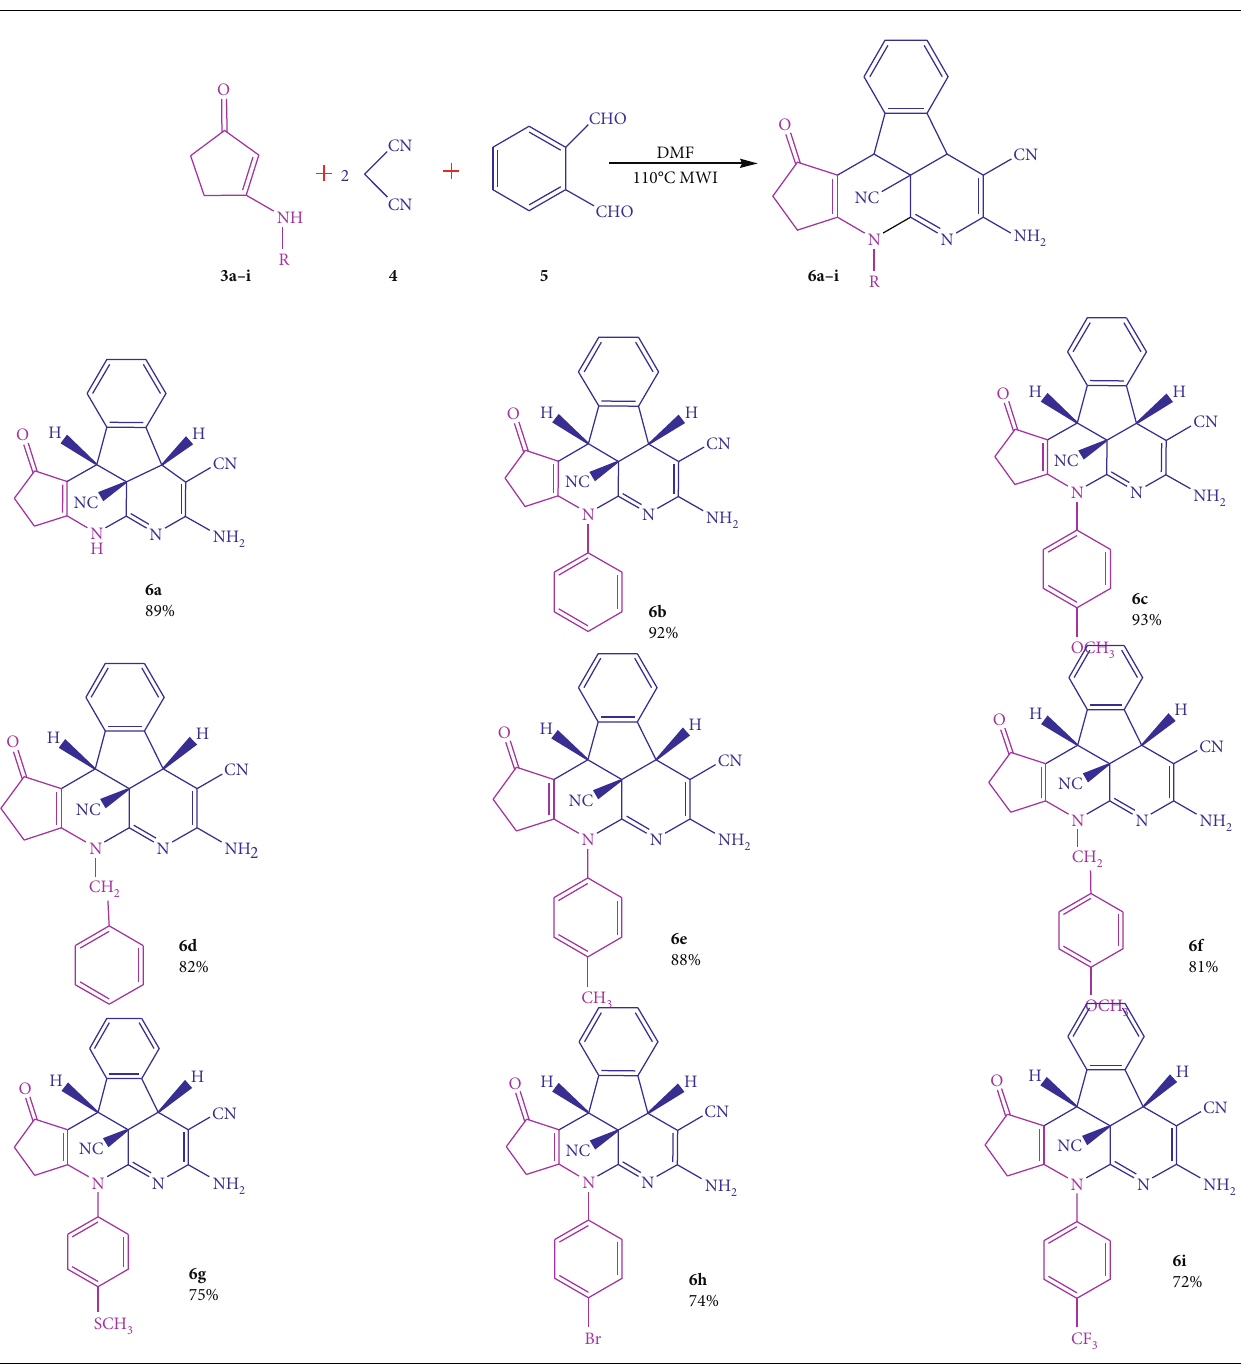
Table 2: Synthesis and substrate scope of compounds 6a-i under microwave